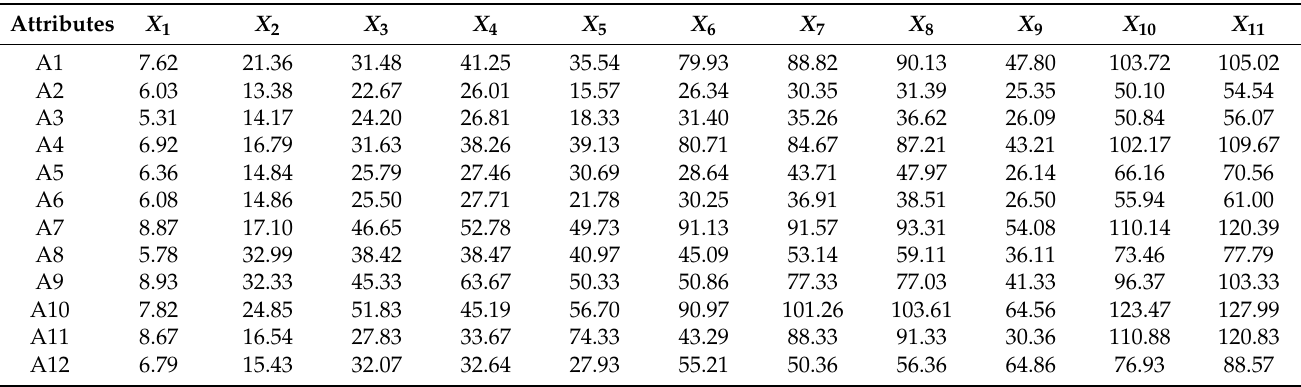
Figure 6. Single FGHP performance evaluation process with node updating (from X 1 to X 6 ), mani- fested as radar charts for performance indicators and weights. Table 4. Expectation (min) of performance indicators for single FGHP according to the attribute classification.